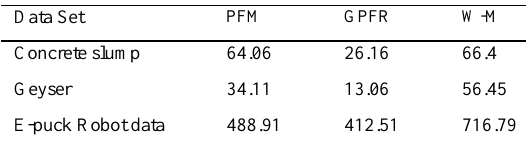
Table 2. Prediction accuracy over three experiments.